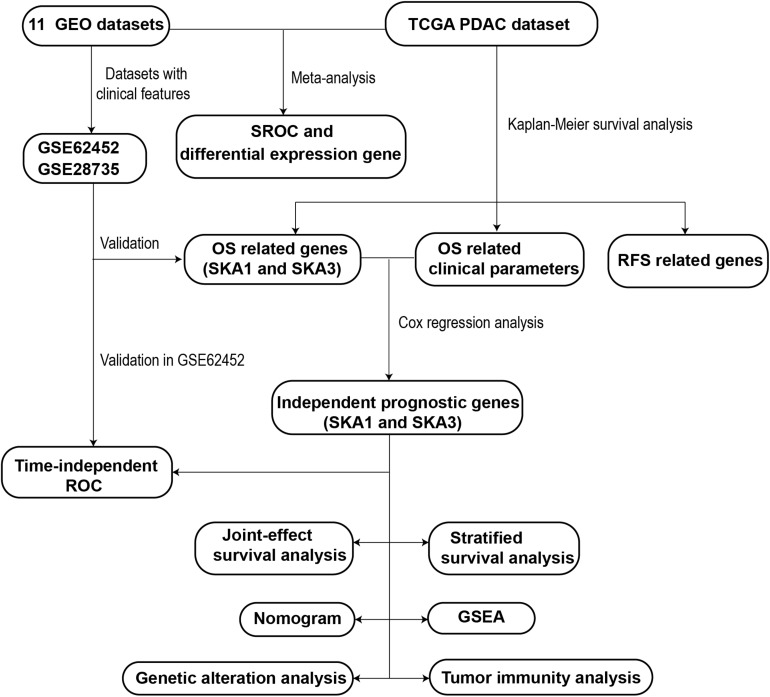
Flowchart presenting the general work flow of this study.